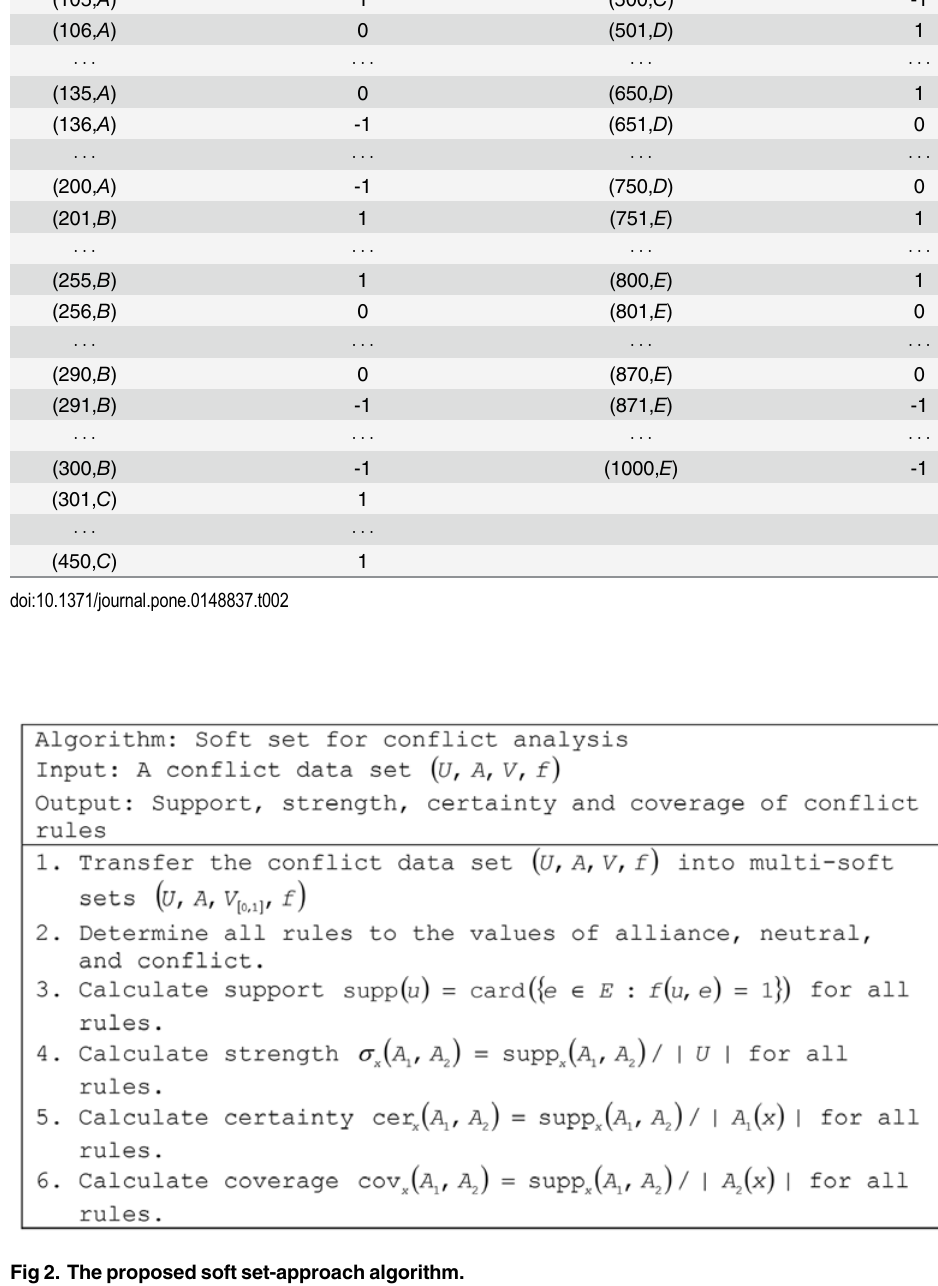
Fig 2. The proposed soft set-approach